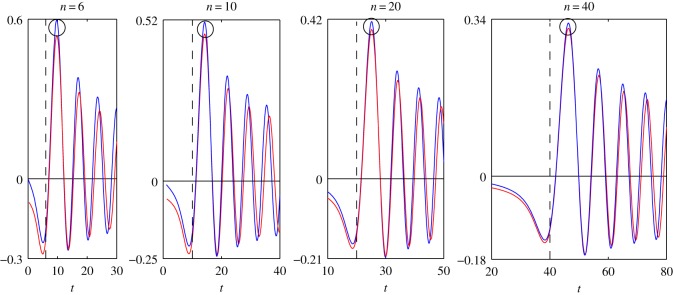
Plots of the functions: s0,n(t)—blue line; F3(n, t)—red line.